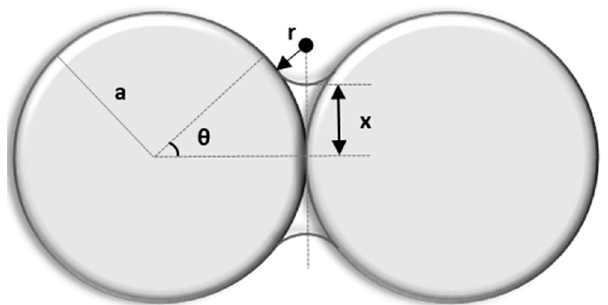
Figure 11. Sintering of two spherical particles for the initial stage of sintering with a neck radius of ‘ x ’ and particle radius of ‘ a ’ with a neck curvature with a radius of ‘ r .’